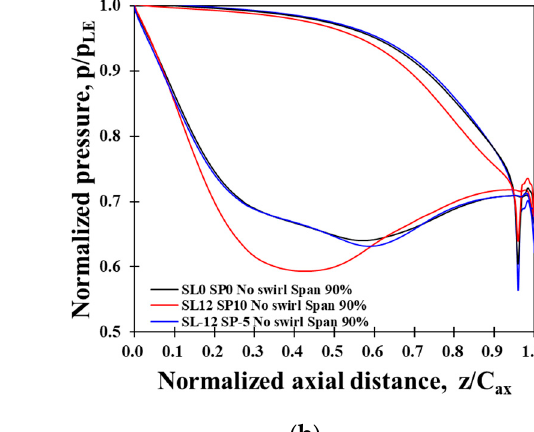
ciency (SL-12 SP-5 No swirl) model: ( a ) Span height 10%; ( b ) Span height 90%. (SL-12 SP-5 No swirl) model: ( a ) Span height 10%; ( b ) Span height 90%.